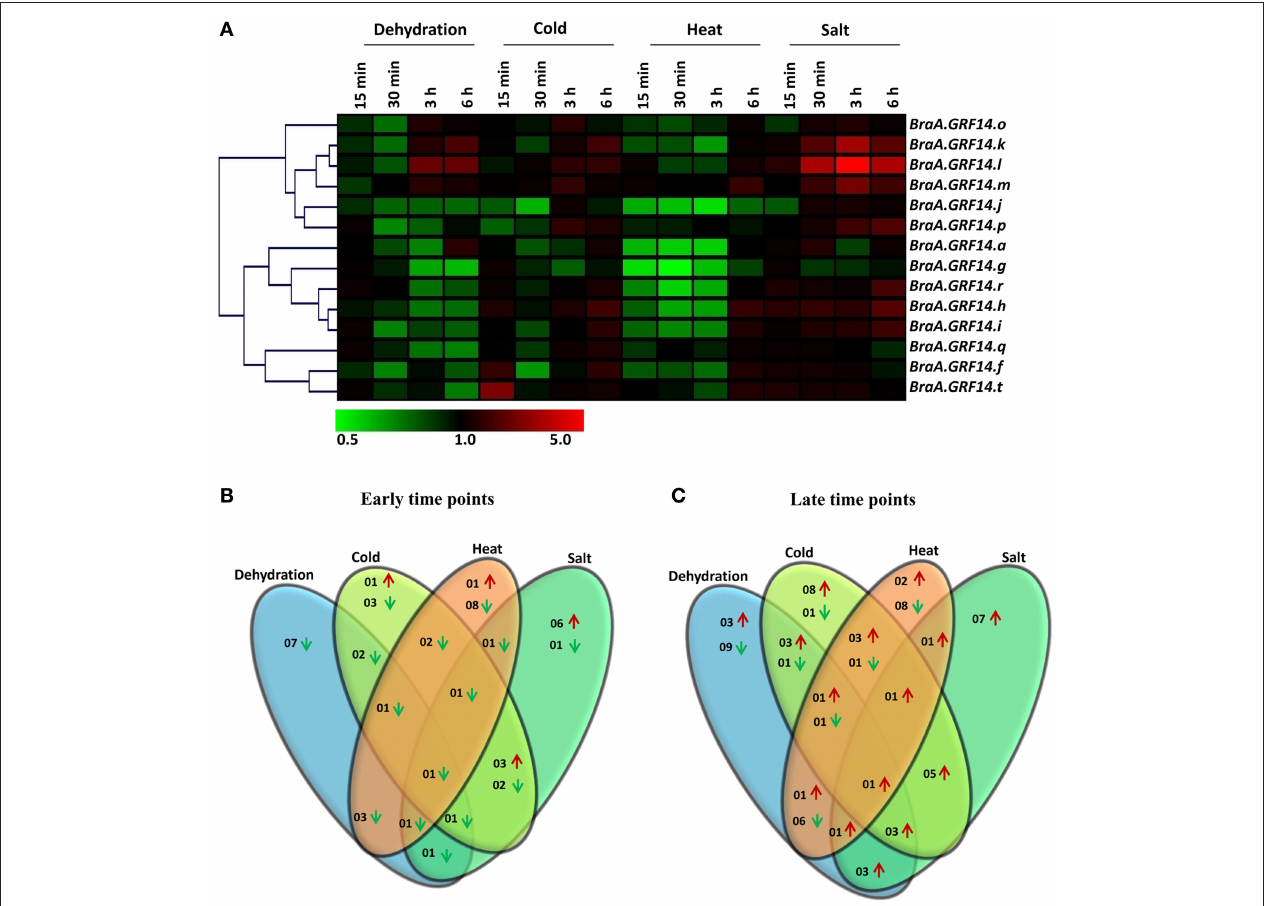
FIGURE 4 | Expression profile of BraA.GRF14 genes in 6 days old B. rapa seedlings in response to abiotic stress conditions. (A) A heat map representing hierarchical clustering of average fold change of BraA.GRF14 genes expression in response to dehydration, cold (4 ◦ C), heat (37 ◦ C), and salt (300mM NaCl) treatments at different time points (15min, 30min, 3h, and 6h) is shown (mentioned at the top of each lane). The mock treated seedlings of same time interval served as control (set at 1) and expression was normalized with ACT2 gene. The color scale representing average signal is shown at the bottom of the heat map. The Venn diagrams represent the total number of BraA.GRF14 genes which were upregulated (red upward arrow) and down-regulated (green downward arrow) during (B) early (15 and 30min), and (C) late (3 and 6h) abiotic stress conditions.